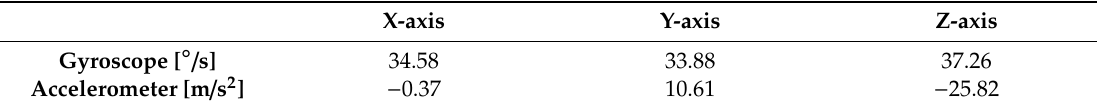
Table 2. O ff set values of MPU6050 used in the flight controller.